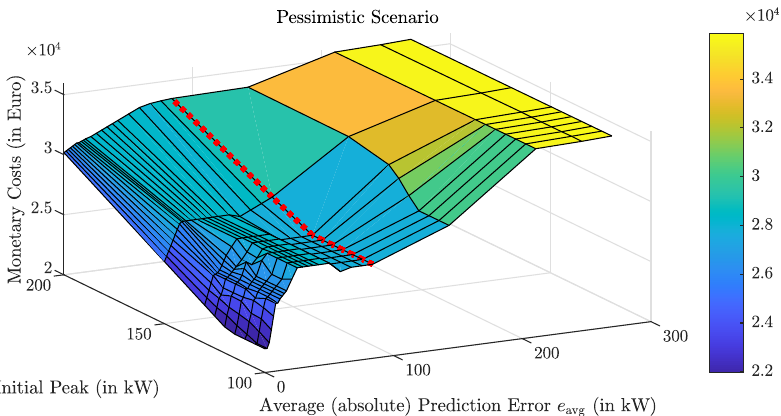
Figure 7. Monetary costs for different prediction errors and initial peaks in the pessimistic scenario. Peak costs of the initial peaks are included. The red dotted line shows the error level with real predictions ( e avg ( s err = 1 ) = 83.76kW).